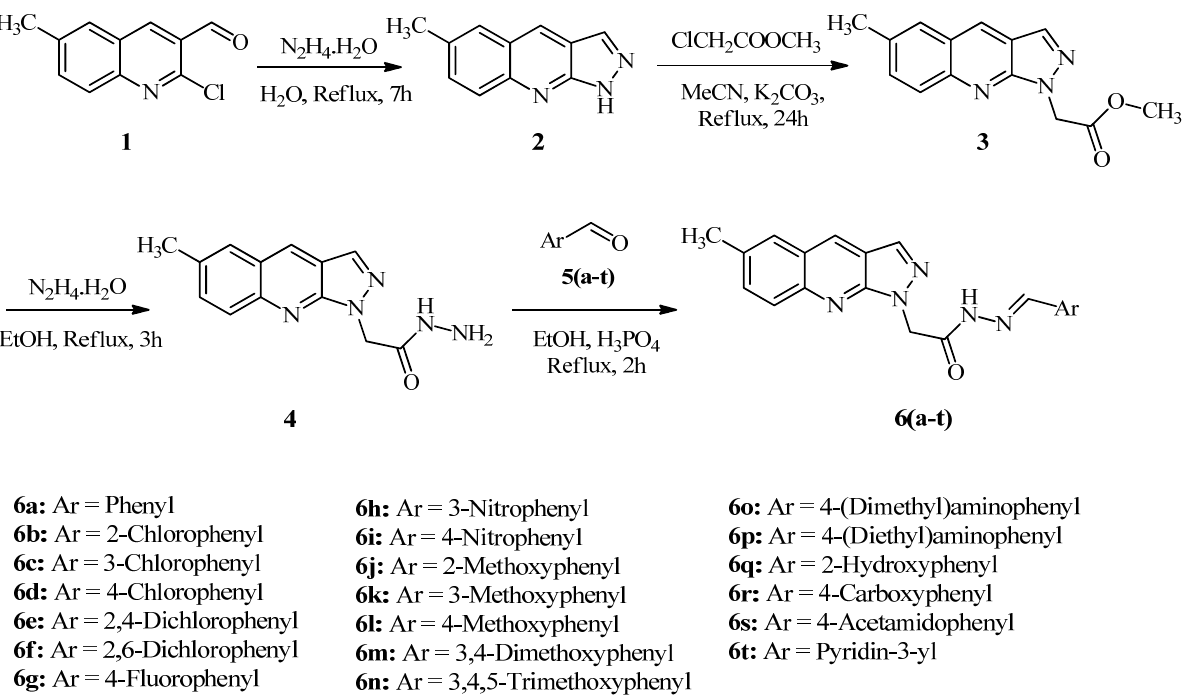
Scheme 1. Synthesis of 6-methyl-1 H -pyrazolo[3,4- b ]quinoline substituted N -acylhydrazones 6 ( a – t